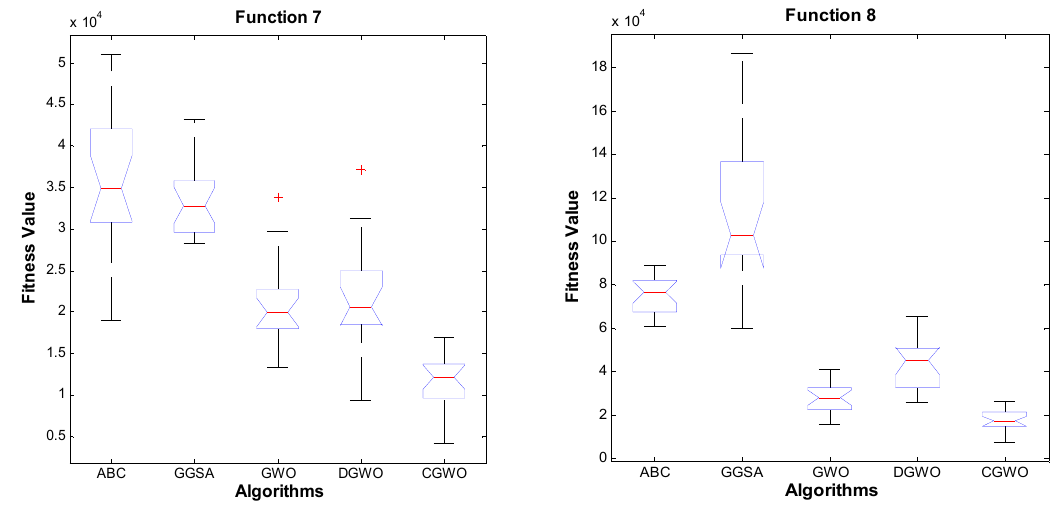
Figure 2. ANOVA tests of ABC, GGSA, GWO, DGWO, and CGWO on unimodal functions with Dim = 30.